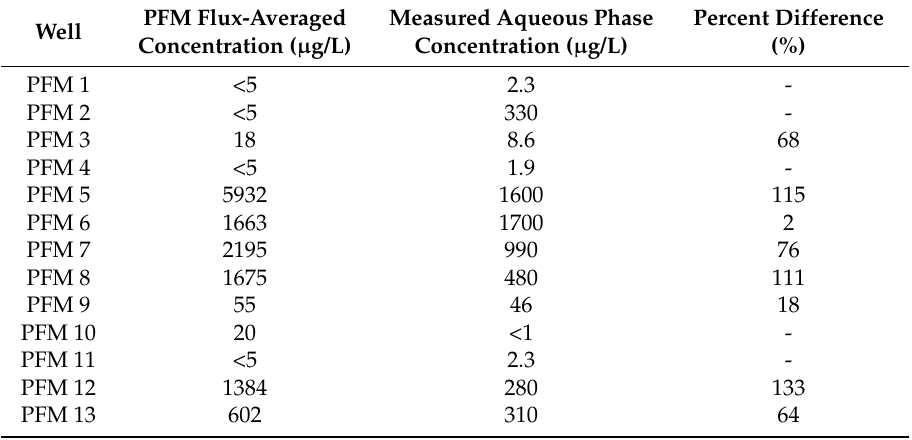
Table 2. Comparison of PFM Results (August 2015) with traditional groundwater data (2013–2014).